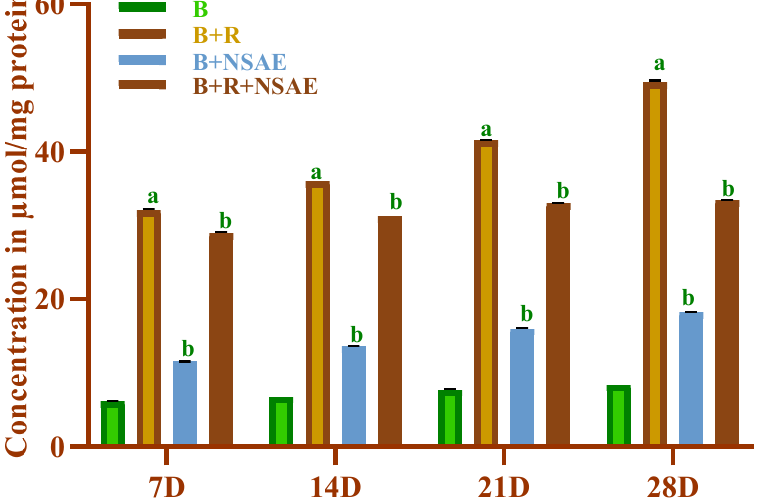
Figure 6. The effect of NSAE on carbonyl group generation in BSA+D-ribose system. B-BSA, B+R=BSA+Ribose, B+NSAE=BSA+ Nigella sativa aqueous extract, and B+R+NSAE= BSA+Ribose+ Nigella sativa aqueous extract. Results are represented as mean ± SD ( n = 5). a p < 0.05 when compared to BSA and b p < 0.05 when compared to BSA+D-ribose.